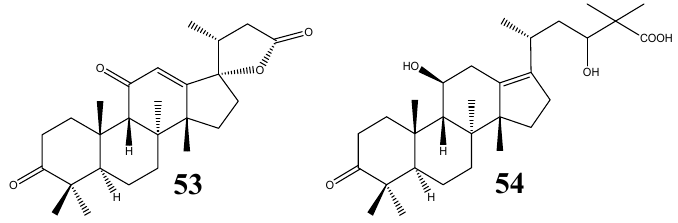
Figure 6. Structures of the nor - and rearranged